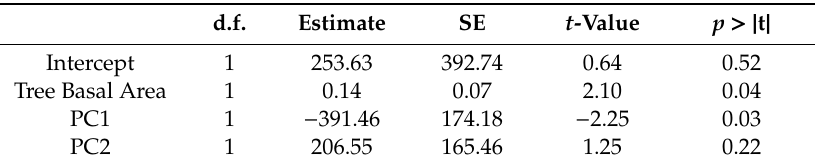
Table 4. Logistic regression estimates for the presence of Coptotermes testaceus colonies in heartwood hollows of the four tree species with N ≥ 20 individuals sampled: P. psilostachya and M. elata ( N = 30), M. bidentata ( N = 28), and A. lecointei ( N = 20).